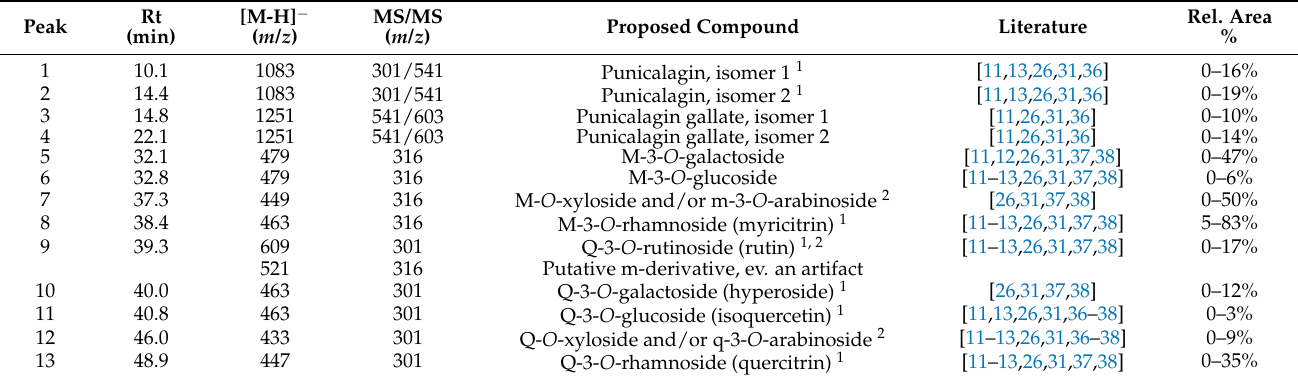
Table 1. HPLC retention times (Rt) of the 13 evaluated peaks, mass data (base ions at negative mode ([M-H] − ), main fragment ions (MS/MS)), peak identification (M = myricetin, Q = quercetin) and relevance of compounds within aqueous extracts of C. creticus (range of relative area percentages at 354 nm). 1 Highlights compounds that were identified via reference compounds; 2 highlights peaks that were shown to be double peaks in a part of the accessions (characteristics of the overlain peak are indicated below the respective line). Identification literature